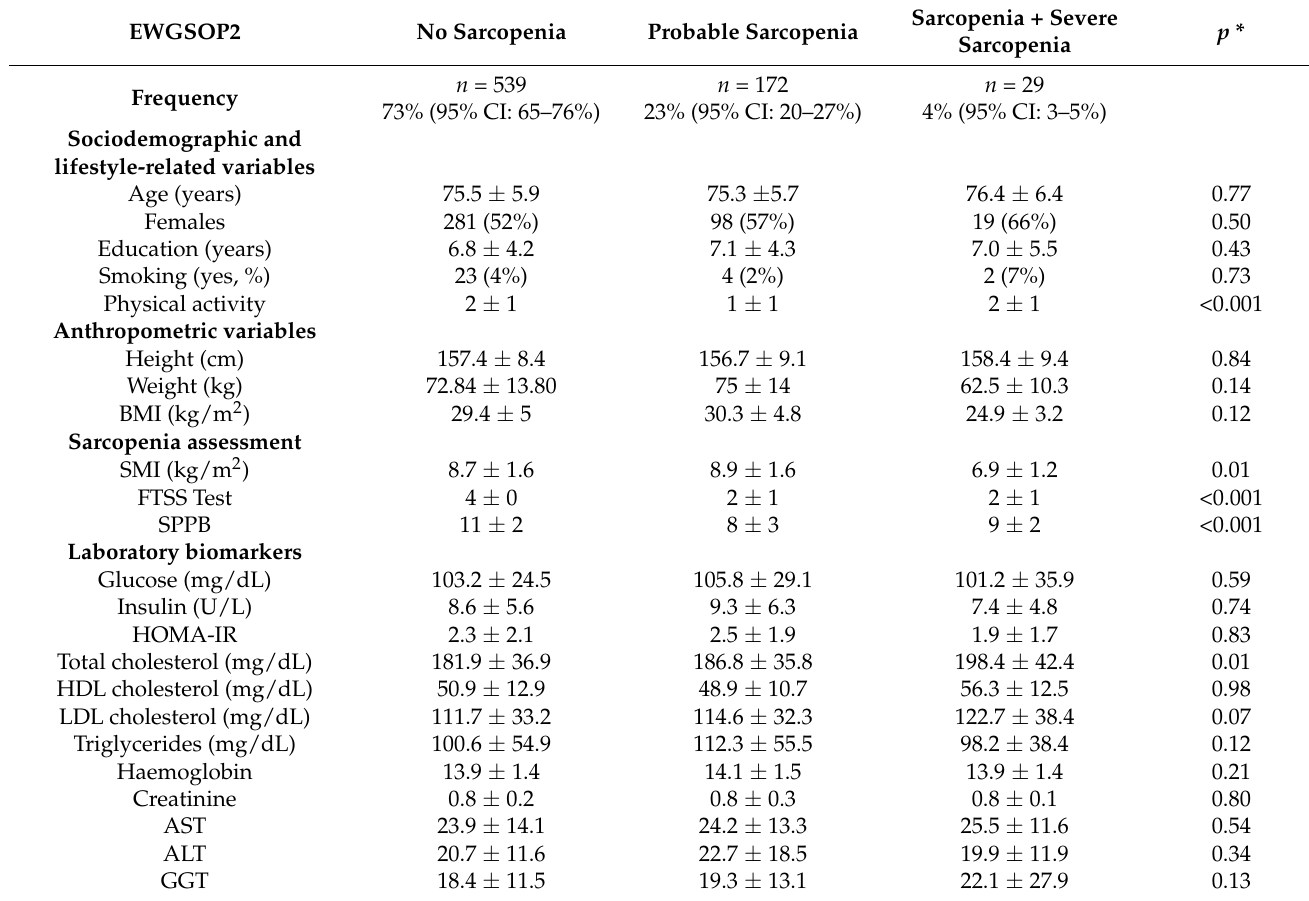
Table 4. Sociodemographic, lifestyle-related, anthropometric, sarcopenia-related, and laboratory biomarker characteristics according to the different sarcopenia-related categories, European Working Group on Sarcopenia in Older People 2019 (EWGSOP2) using skeletal muscle index (SMI) to define muscle mass. The Salus in Apulia Study ( n = 740). Sarcopenia + Severe EWGSOP2 No Sarcopenia Probable Sarcopenia